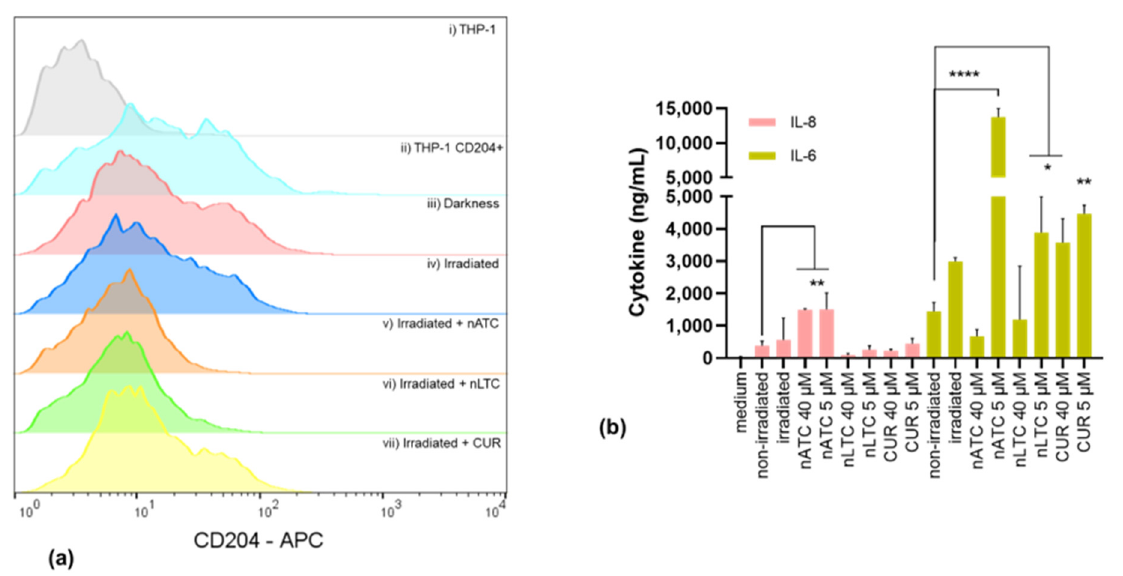
Figure 7. Tumor-associated macrophages (TAM) modulation. ( a ) Expression of CD204 in THP-1 cells line transformed to macrophages, (i) THP-1 control, (ii) THP-1 with CD204 labeling, (iii) THP-1 after 24 h incubation with supernatants obtained from non-irradiated A549 cells, (iv) THP-1 after 24 h incubation with supernatants obtained from A549 cells irradiated with a fluence of 9 J/cm 2 , (v) THP-1 after 24 h incubation with supernatants of A549 previously incubated with 5 µ M nATC, (vi) 5 µ M nLTC and (vii) 5 µ M CUR and irradiated. ( b ) IL-8 and IL-6 quantification in supernatants of THP-1 cells, cells without treatment (Medium), after 24 h incubation with supernatants of irradiated A549, or non-irradiated A549, or A549 incubated with 5 μ M or 40 μ M nATC, nLTC, or free CUR and irradiated. Statistical significance compared with non-irradiated control was determined using a one-way ANOVA followed by Dunnet’s test, * p < 0.05; ** p < 0.01, **** p < 0.0001.